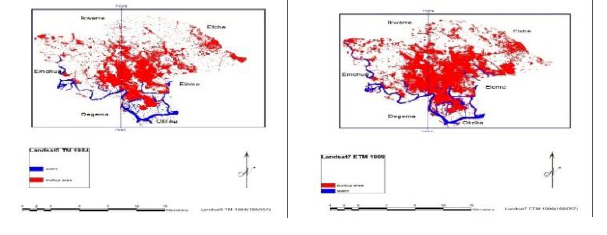
Figure 6: Built up Area as at 1984 Figure 7: Built up Area as at 1999